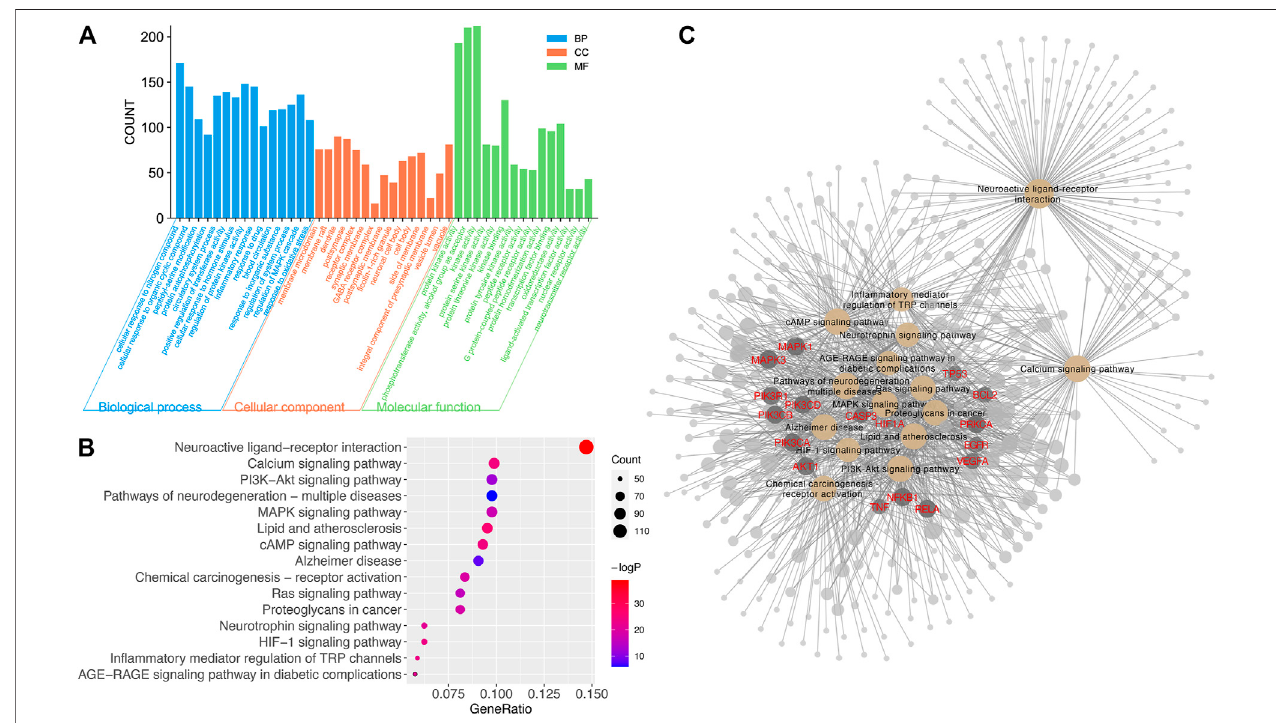
FIGURE 5 | The result of GO and KEGG analyses. (A) The distribution of GO entries in BP, MF, and CC (top 15 according to FDR < 0.05). (B) Top 15 enriched KEGGitemsofpredictedtargets(FDR < 0.05). (C) Enrichedtargetsintop15KEGGitems.Theyellownoderepresented KEGGitems.Thedarkgraynodewithredgene name represented important targets. The node with a larger size contributed more to the